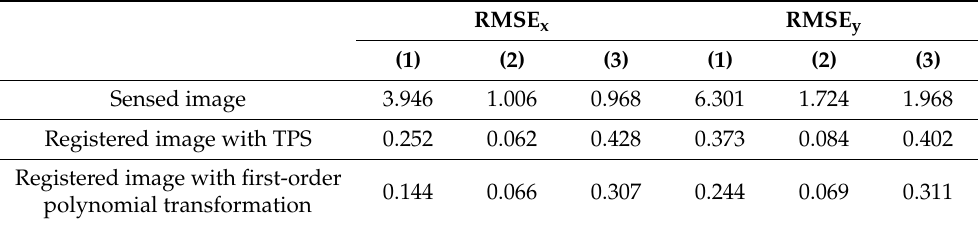
Table 7. Registration accuracy using two transformation functions. Thin plate spline (TPS). (1)